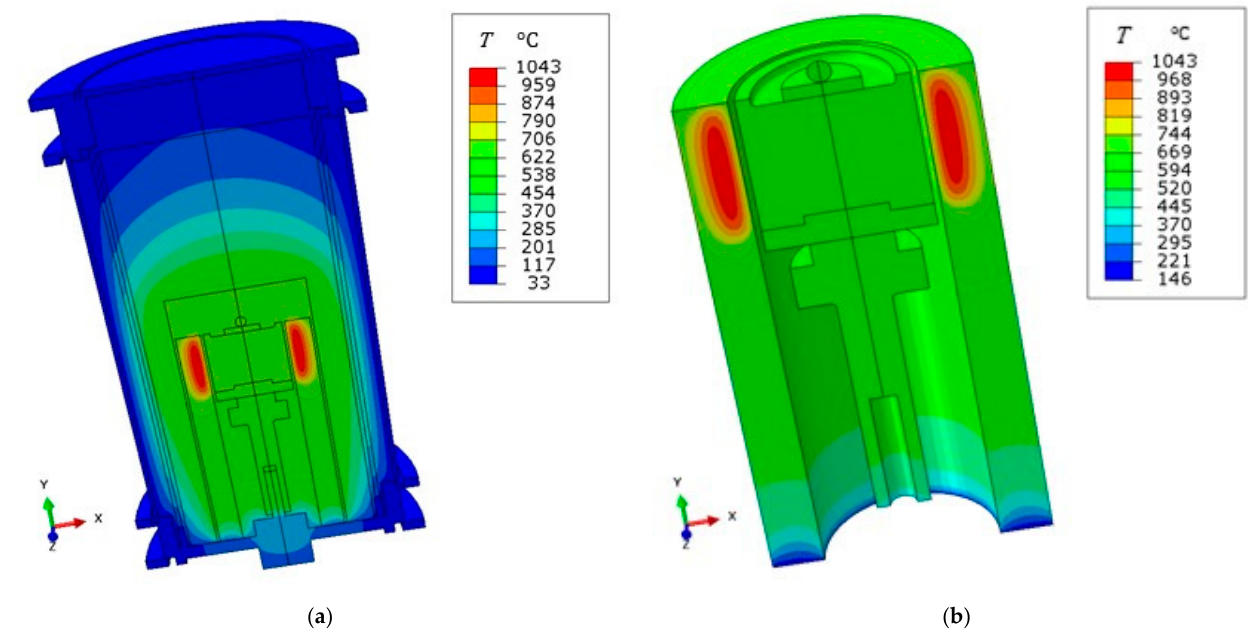
Figure 14. ( a ) Steady state temperature field provided by an accurate axisymmetric finite element model of the entire furnace. ( b ) Detail with a different temperature and color interval, including only the sample holder with its rotation transmission system, and the heating cylindrical element. Three dimensional rendering was